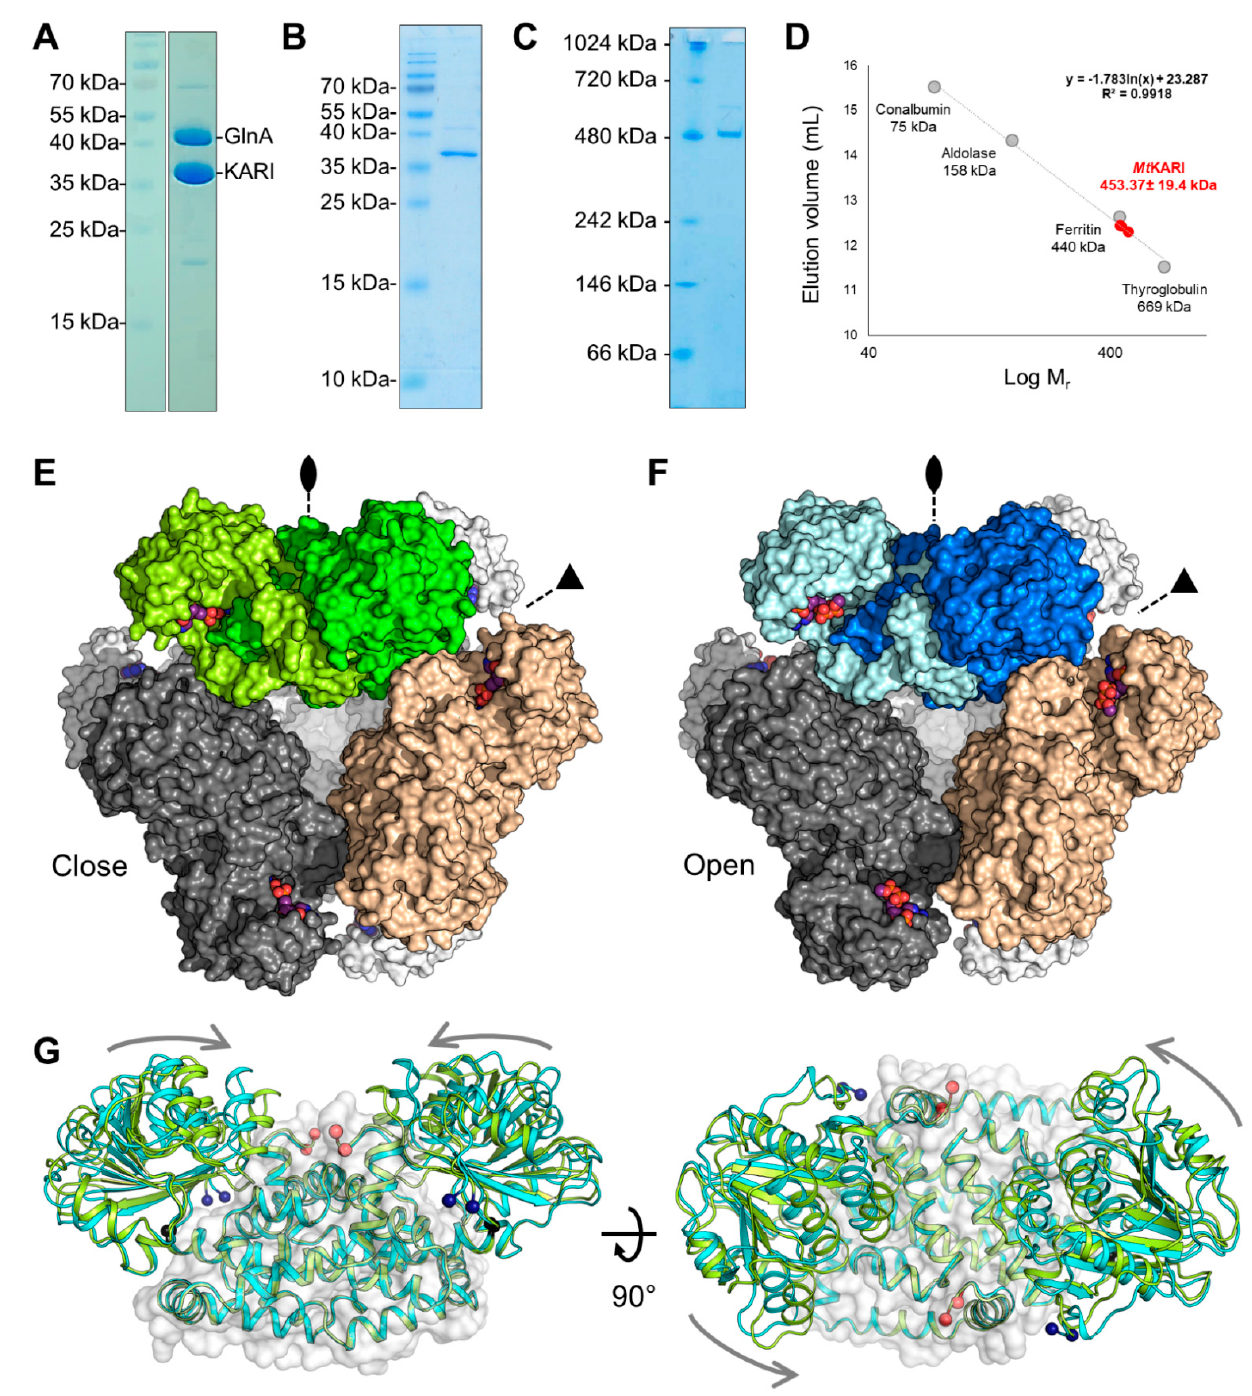
Figure 1. Purification and overall structure of Mt KARI. ( A ) SDS-PAGE of the sample used for crystallisation. ( B ) SDS and ( C ) hrCN-PAGE of enriched Mt KARI (2 µ g) used for determination of the oligomeric state. ( D ) The dodecameric state of Mt KARI was determined by size exclusion chromatography (n = 3, see Figure S1). ( E , F ) Dodecameric structures of the closed ( E , green surface) and open conformation ( F , blue surface). Ligands are represented by balls and sticks with carbon, oxygen, nitrogen, phosphorus and Mg 2+ coloured in purple, red, blue, orange and light green, respectively. ( G ) Superposition of the closed (green) and open (cyan) forms of Mt KARI represented as a cartoon. The common part (knot domain) is shown as a transparent surface. Blue and red balls indicate the positions of the N- and C-termini, respectively. The black balls indicate the hinge position. Grey arrows symbolise the closure movements.